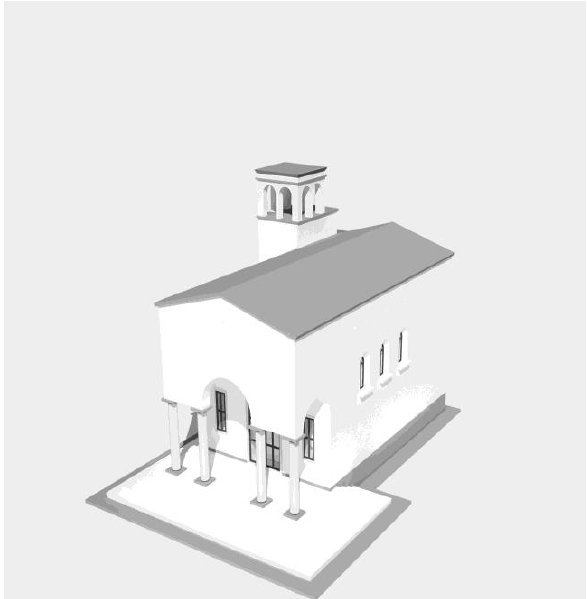
Figure 8. The Royal Park of Tirana. 3D survey of the Church.